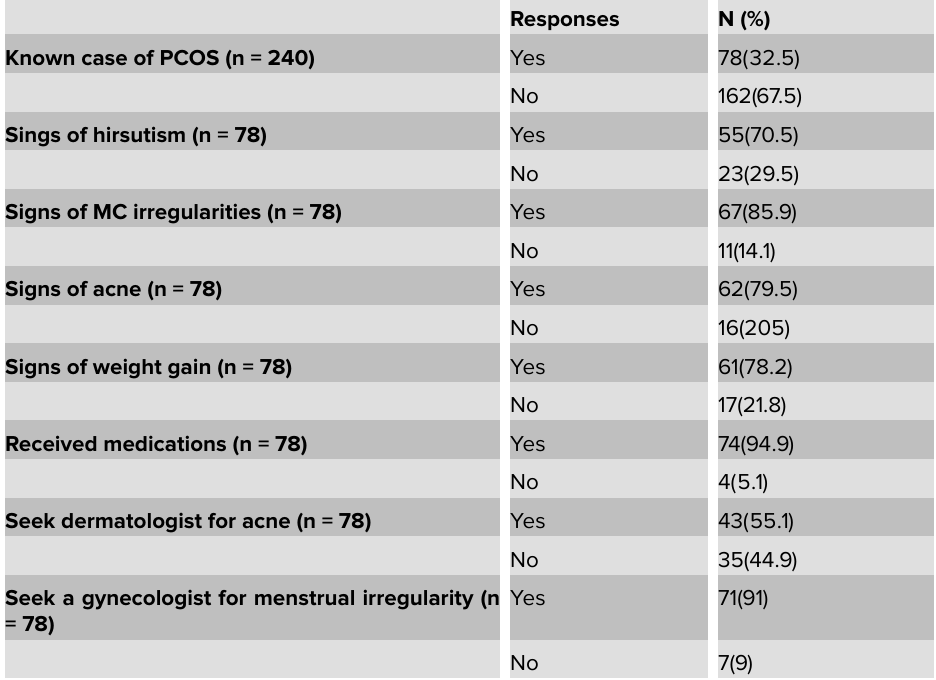
Table 4: Predictors of knowledge about PCOS by using logistic regression test: ( n = 240).